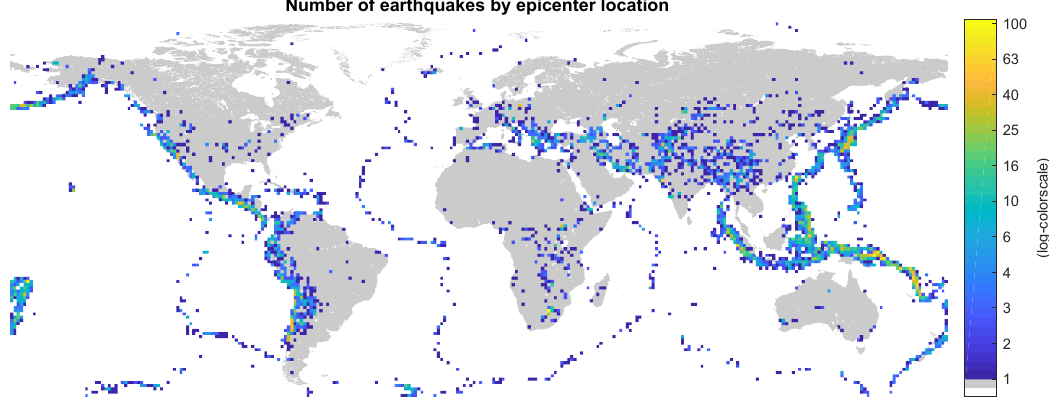
Figure C1. Epicenter locations of the sample of 12388 earthquakes in the dataset with ShakeMaps and magnitude 4.5 or greater. The map shows the number of earthquakes in the dataset which have their epicenter in the corresponding 1.25 × 1.25 ◦ grid cell.